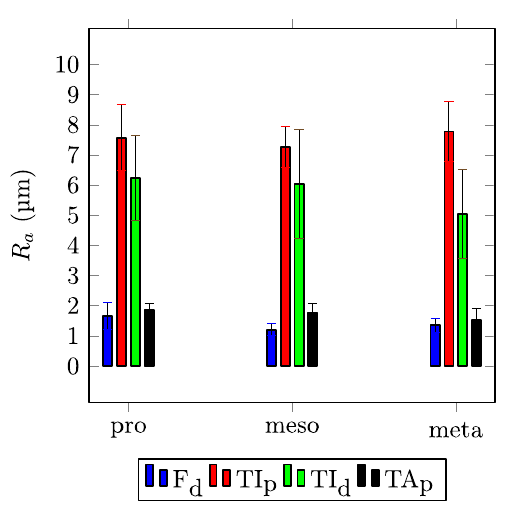
Figure 6. Roughness ( R a ) of the condyle in the femur–tibia (F d and TI p ) and the tibia–tarsus (TI d and TA p ) leg joints measured by white light interferometry (WLI). Error bars show standard deviations of the means. F d : the distal condyle of the femur; TI p : the proximal condyle of the tibia; TI d : the distal condyle of the tibia; TA p : the proximal condyle of the tarsus; pro: prothoracic leg; meso: mesothoracic leg; meta: metathoracic leg.